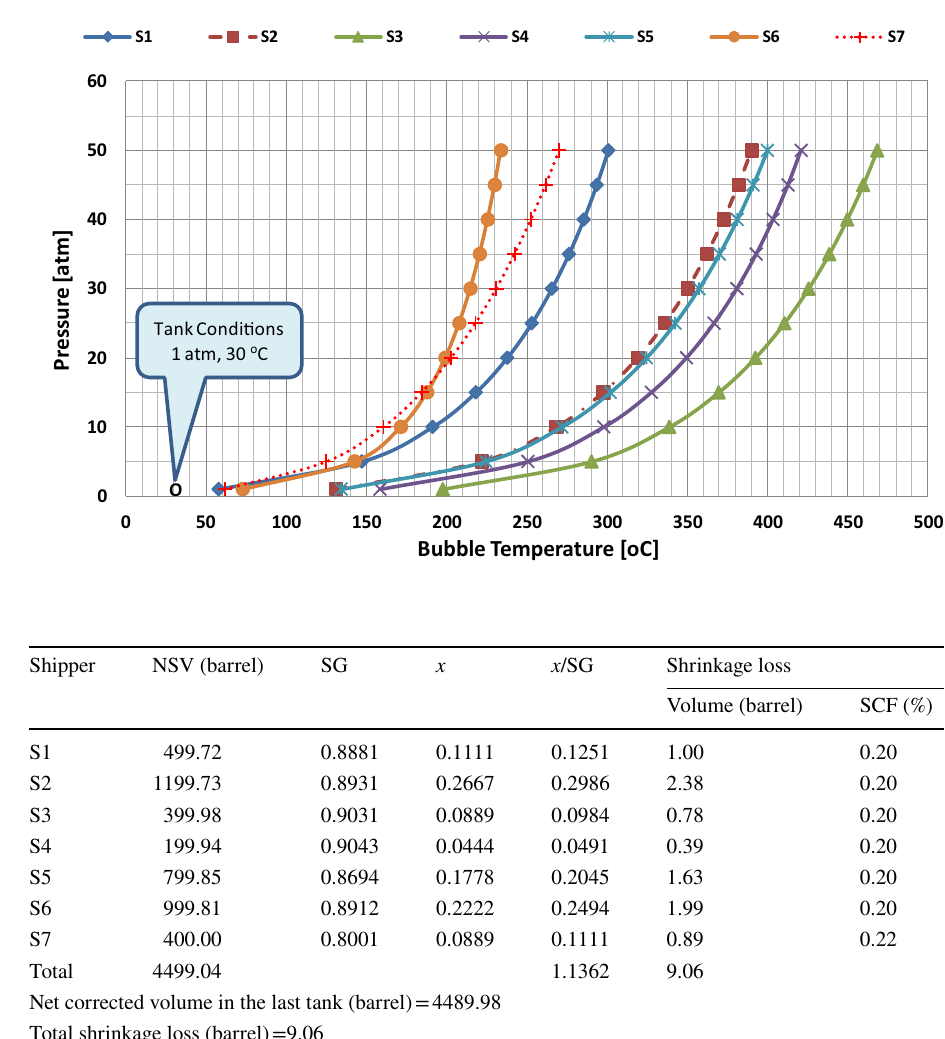
Fig. 7 Correlation of vapor pressure and bubble temperature